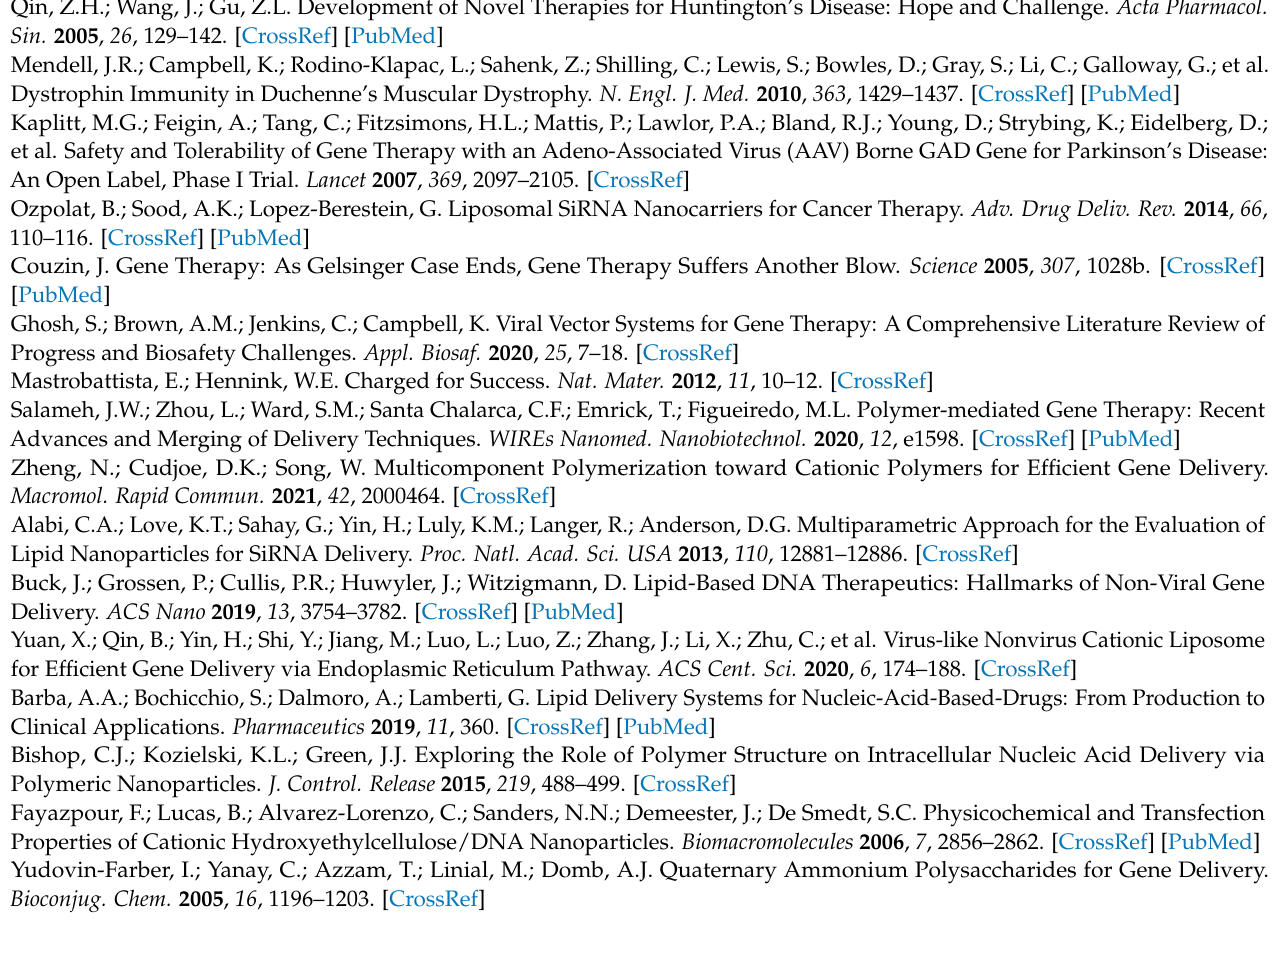
Figure S2: Acid-base titration profiles of nanogels and PEI-25kDa, Figure S3: DNA protection against serum nucleases in nanogel/pDNA complexes, Figure S4: Cytotoxicity of nanogels and nanogel/pDNA complexes in HEK293T cells, Figure S5: Intracellular localization of Cy5-labeled pDNA (red) mediated by nanogels in HEK293 cells, observed by CLSM at 4 h post-incubation, Figure S6: CLSM images of HEK293 cells after incubation with complexes of nanogels or PEI-25kDa and TAMRA-labeled ODNs for 4